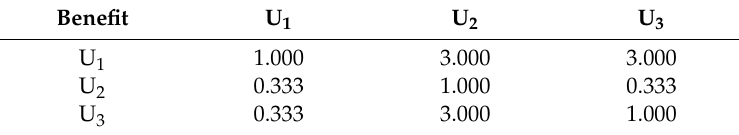
Table 3. Primitive weight matrix of comprehensive benefits.